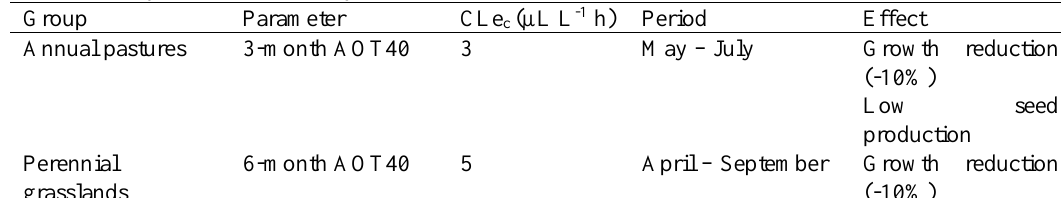
Table S1. Ozone threshold values and concentration-based ozone critical levels (CLe c ) for plant protection established within the CLTRAP (2011), and the ozone objective values designated by the EU Air Quality Directive